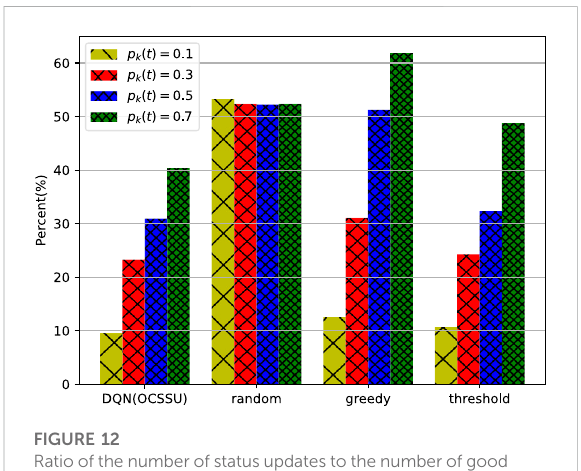
FIGURE 12 Ratio of the number of status updates to the number of good channel states of each policy under different user request